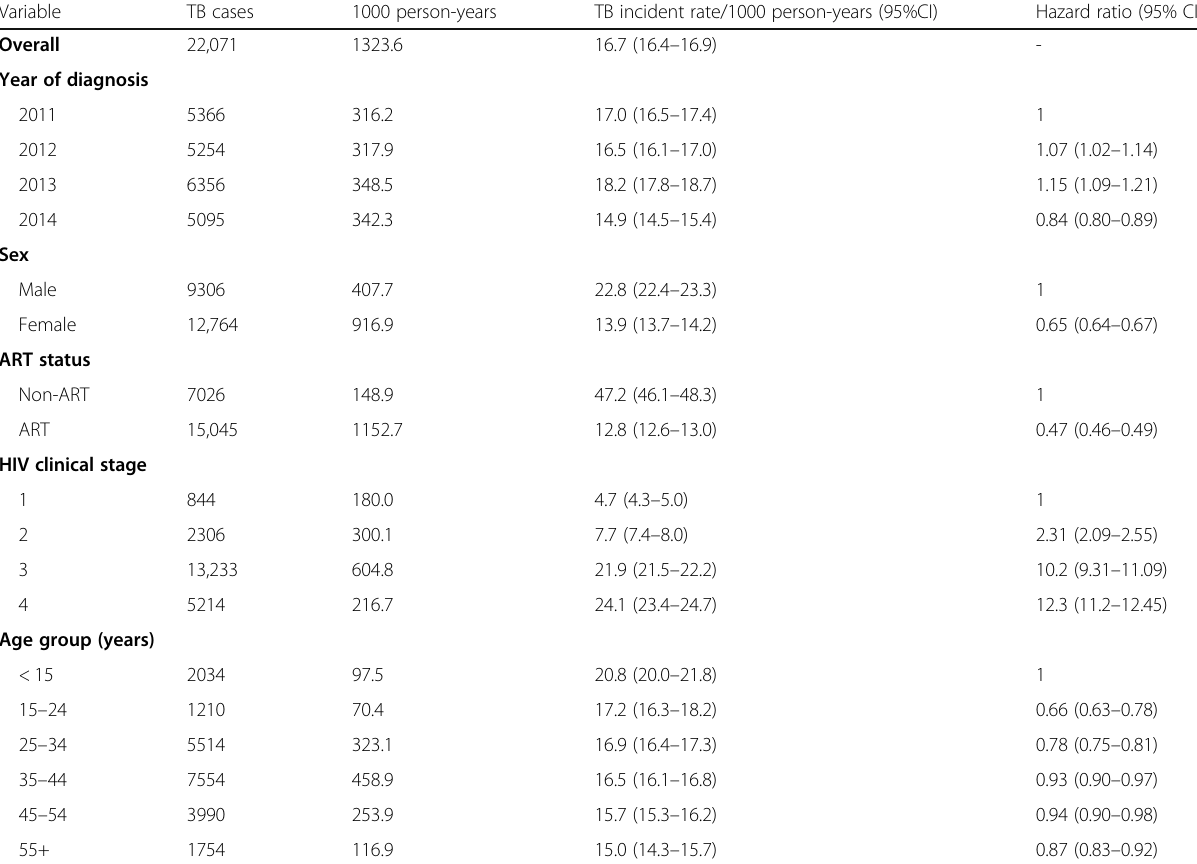
Table 3 Incidence of tuberculosis among individuals enrolled in HIV care, treatment, and support program in Tanzania in 2011 to 2014